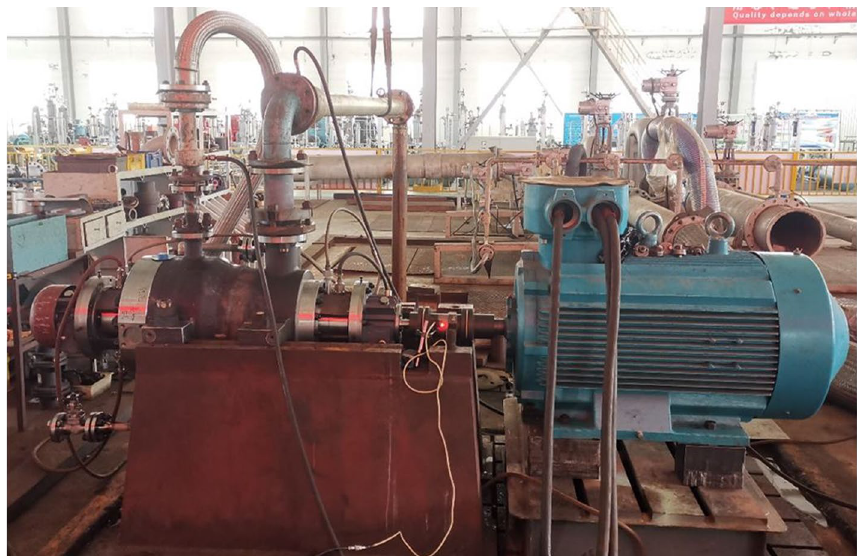
Figure 7. Centrifugal pump test platform.